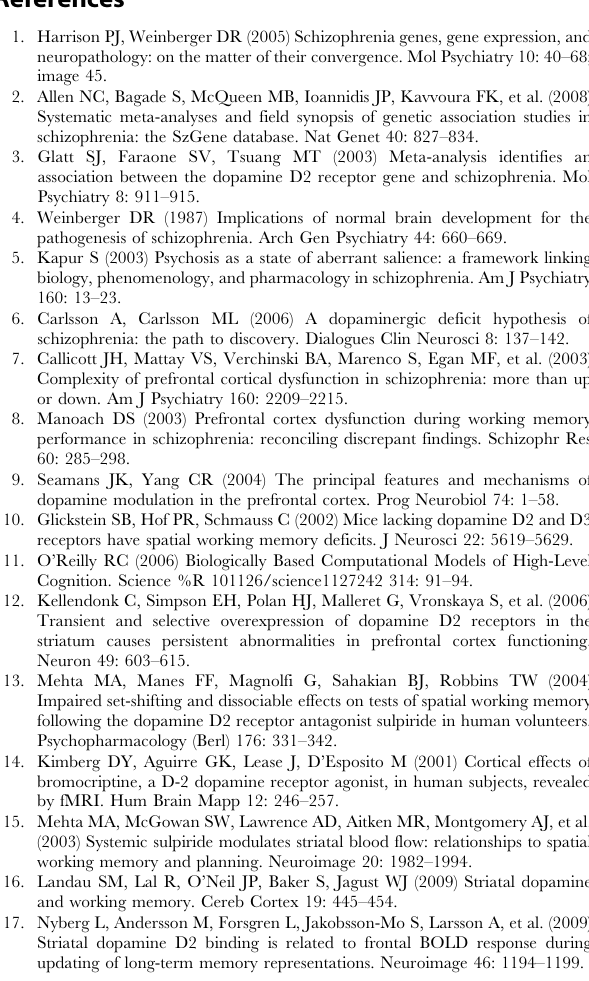
Table S1 Demographics of all subjects included in the study divided by rs1076560 genotype.